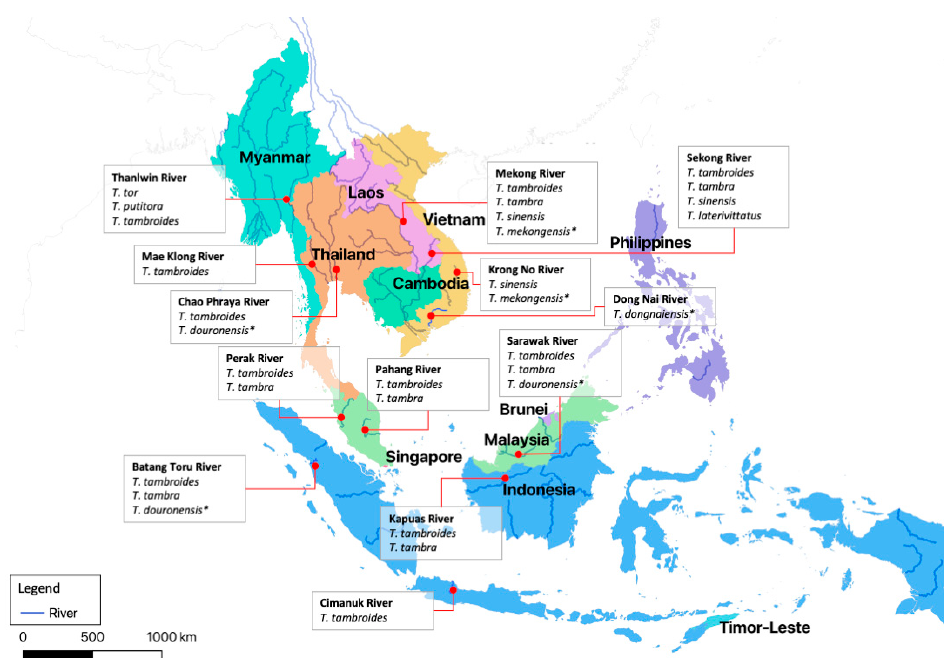
Figure 2. Geographical distribution of Tor species in the SE Asian region. Source: The GIS map was generated with QGIS software version 3.10. The map was obtained from Google Maps databases. The locations of the rivers were obtained from Google Maps and River, Lake, and Centreline QGIS databases. The distribution and locality of Tor species were generated based on the reports from previous ichthyofauna studies conducted in SE Asia [2,15,16,18,48–56]. Note: * symbol is represent uncertain